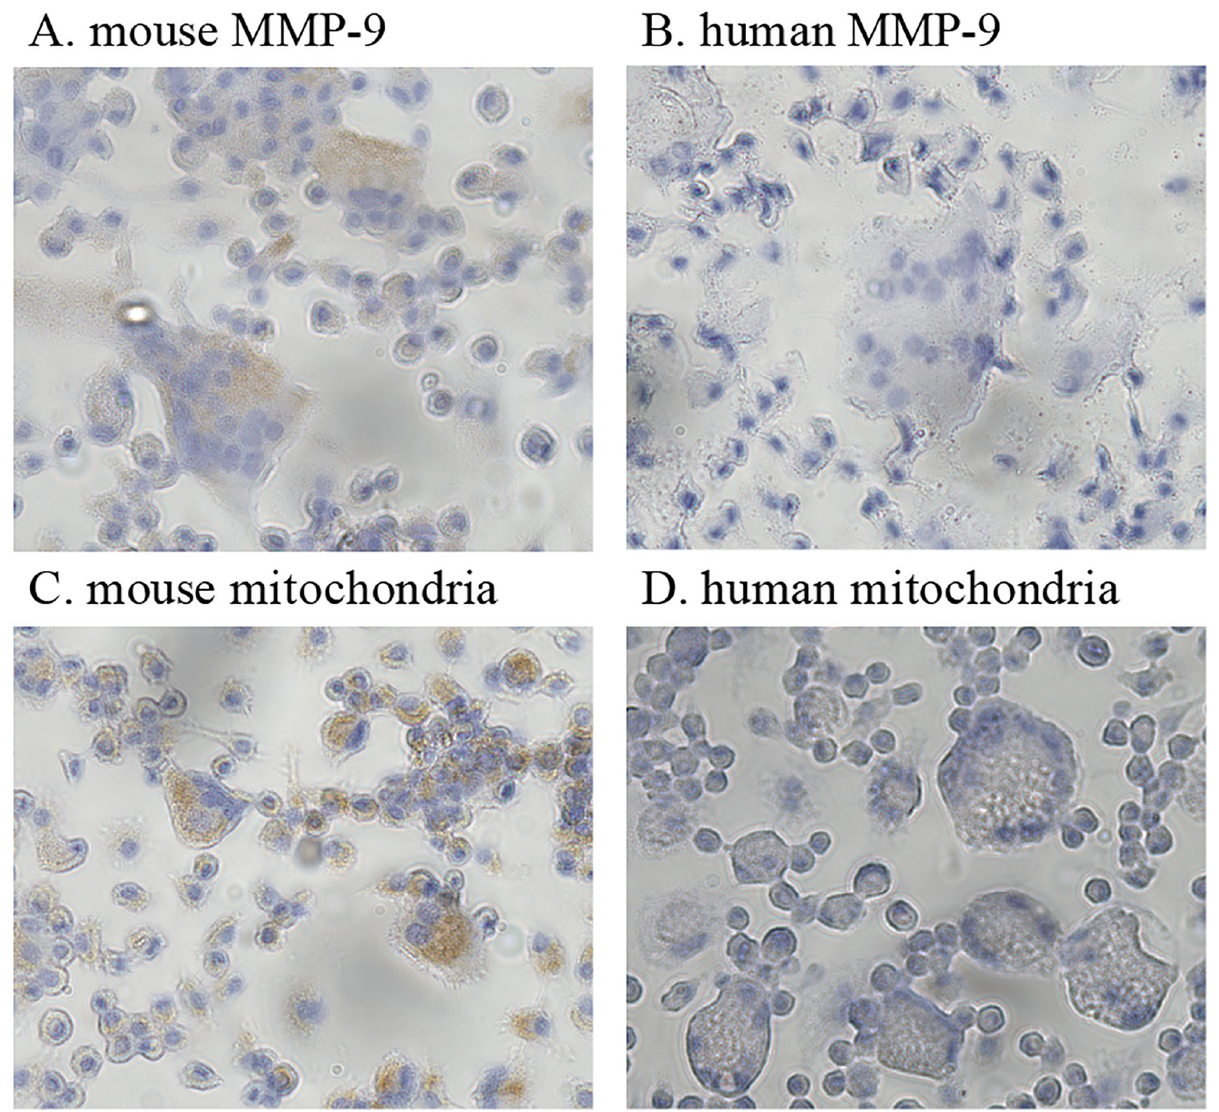
Fig 5. Cytochemistry of cultured mouse osteoclast progenitor cells in the presence of M-CSF and RANKL differentiation signals. (A–D) Cultured cells from mouse osteoclast progenitor cells. (A) Cultured cells immunostained with an antibody that reacts with mouse MMP-9. Multinucleated cells positive for MMP-9 stained brown with the anti-MMP-9 antibody (dilution, 1:100). (B) Cultured cells immunostained with an antibody specific to the human MMP-9. Multinucleated cells were not stained (antibody dilution, 1:12.5). (C) Cultured cells immunostained with an antibody that reacts with mouse mitochondrial protein. Multinucleated cells positive for the mouse mitochondrial protein stained brown with the anti-mitochondrial antibody (dilution, 1:360). (D) Cultured cells immunostained with an antibody specific to human mitochondrial protein. Multinucleated cells were not stained (antibody dilution, 1:10). Original magnification, 400 ×